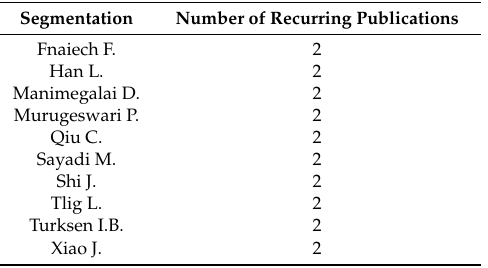
Figure 8. Number of published papers by year for segmentation research papers. Table 5. Authors with recurring publication in the area of segmentation.